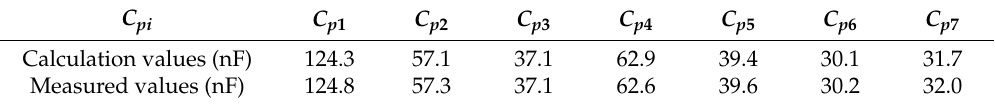
Table 5. The calculation values and the measured values of the multiple